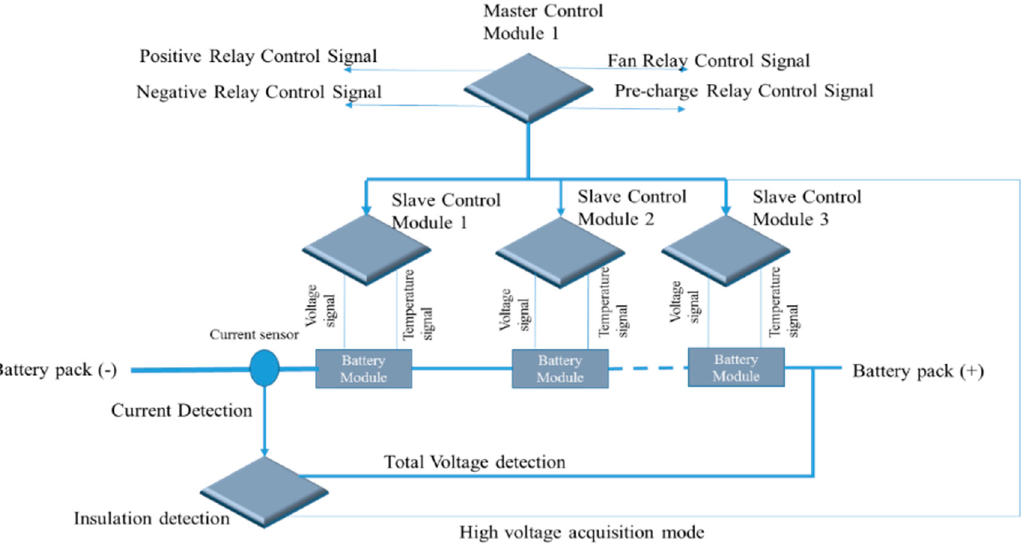
Figure 6. Master-slave architecture of BMS.